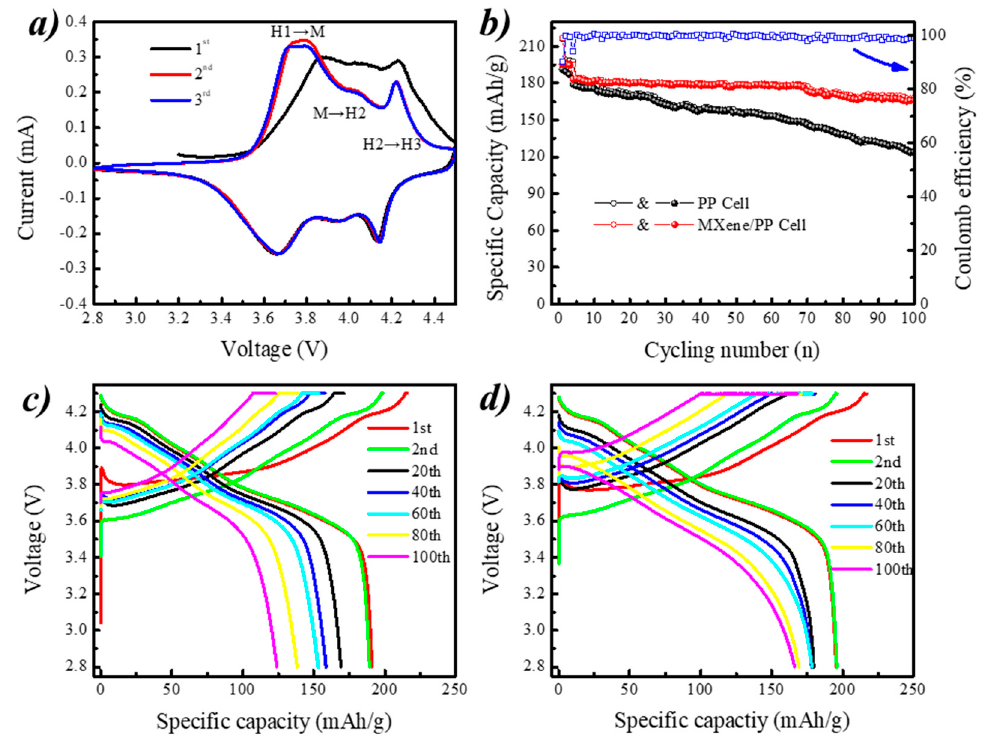
Figure 5. ( a ) CV curve of MXene/PP cell and ( b – d ) cycling performances of PP and MXene/PP cells.